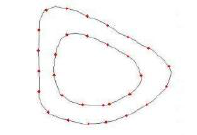
Figure 8 . Discrete point set